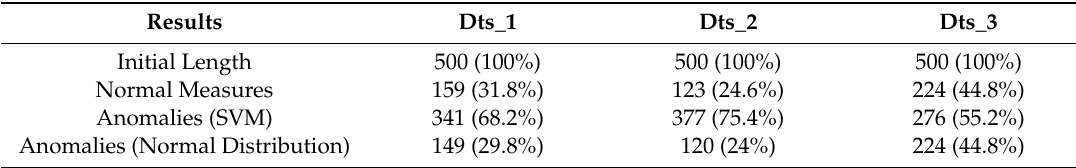
Table 15. Summary of the achieved results and ratios associated to initial